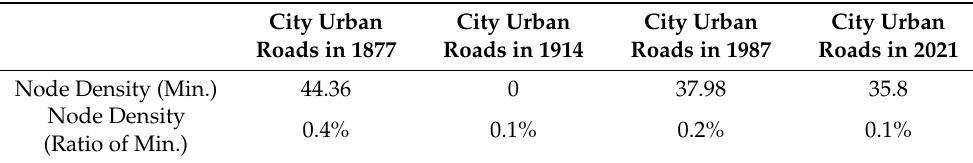
Table 1. Road Node Density in the Changsha Historic Urban Area in Various Periods.